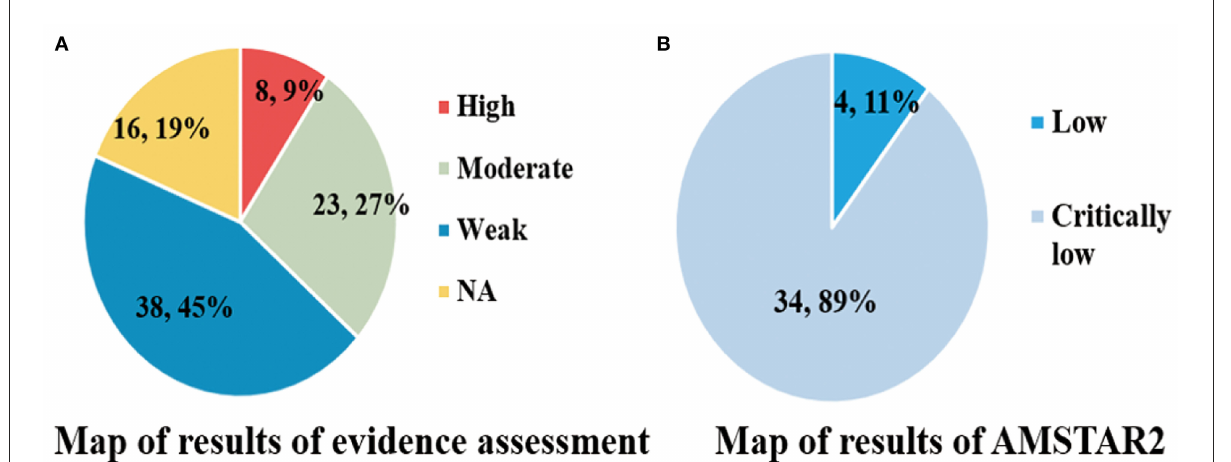
FIGURE9 (A,B) Map of results of evidence assessment and AMSTAR